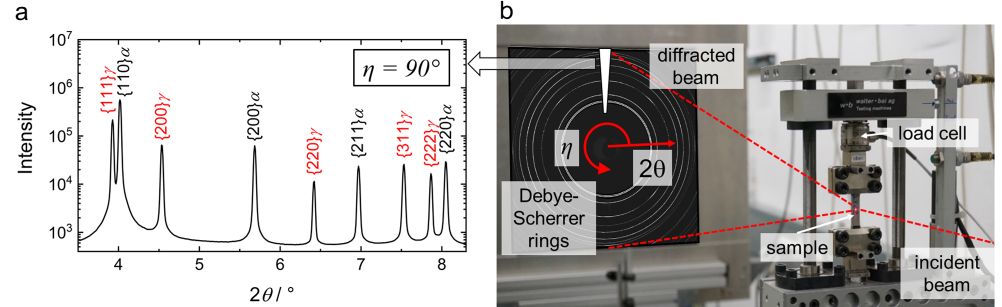
Figure 4. Exemplary diffraction profile of the duplex stainless steel sample after azimuthal integration of a segment over ± 2.5 ◦ at η = 90 ◦ ( a ) and experimental setup with tensile testing machine and flat-panel detector ( b